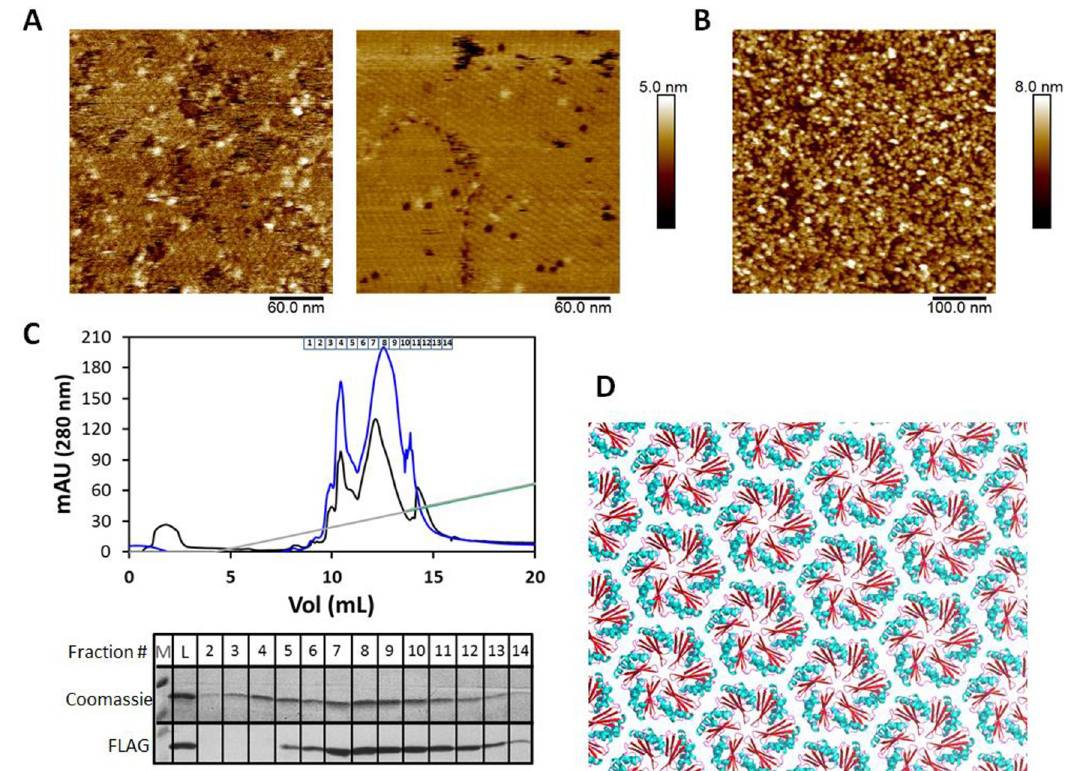
Fig 5. Structural analysis of Syn6803 CcmK hetero-hexamers. AFM images recorded after adsorption on mica of 70 ng of CcmK3/ K4 (panel A , left) or180 ng of CcmK1/K2 hetero-hexamers ( B) , in sodium phosphate buffer at pH 6.0. For comparison, 2D arrangement obtained under similar conditions after deposition of 70 ng of CcmK4 homohexamer ( A , right ). C , pIsep-FPLC purification chromatogram after injection of His 4 -CcmK4/CcmK3-FLAG hetero-hexamer sample (two different runs are shown, in black and blue trace). Elution was performed with a linear gradient of a polybuffer solution at pH 5 (gray line). Approximate fraction emplacements are indicated above the chromatogram. Below is shown the 10 to 15 kDa region after migration of different fractions on a SDS-PAGE gel. Please notice that His 4 -CcmK4 and CcmK3-FLAG bands could not be resolved. FLAG-signals detected by WB are shown below. Bands were delayed with regard to Coomassie-stained bands. Pooled fractions 8 and 9 were selected for crystallographic experiments. D , Crystallization of that pooled fraction permitted to solve structures that revealed the sole presence of CcmK4. Shown is the resulting CcmK4 crystal packing, revealing a molecular layer with hexamers arranged following a uniform orientation (shown with CcmK4 convex side facing up). Interhexamer spacing is 7,1 nm. A ribbon view is presented, with elements colored in accordance to secondary structure